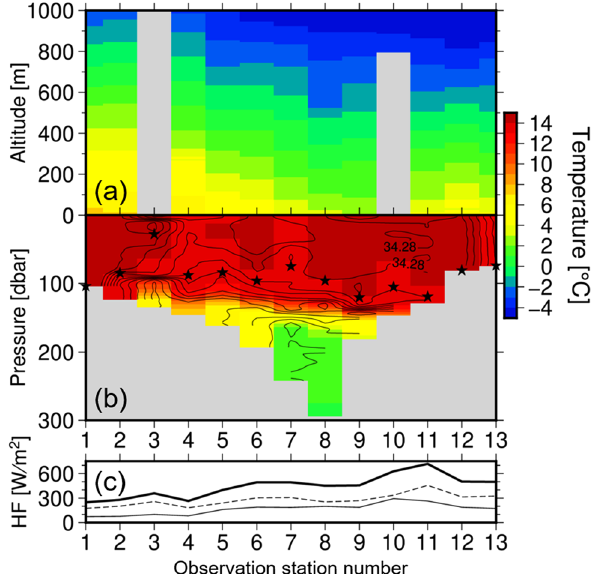
Figure 3. Ocean near-surface temperatures were much higher than overlying atmosphere under the JPCZ. ( a ) Vertical cross sections of atmospheric temperature and ( b ) underlying oceanic temperature along the observation stations. To make the atmosphere–ocean interaction easier to see, the colour intensity was kept the same for both atmospheric and oceanic temperatures as indicated on the right side of the figure. Contours in the ocean denote salinity with interval of 0.02. Stars indicate ocean mixed layer depth defined as the depth at which density increases by 0.03 kg m −3 from its 10-dbar depth value 23 . ( c ) Sum of latent and sensible heat fluxes from the ocean to the atmosphere. Positive value means upward flux. The thin, broken, and bold lines indicate sensible, latent, and total heat flux,